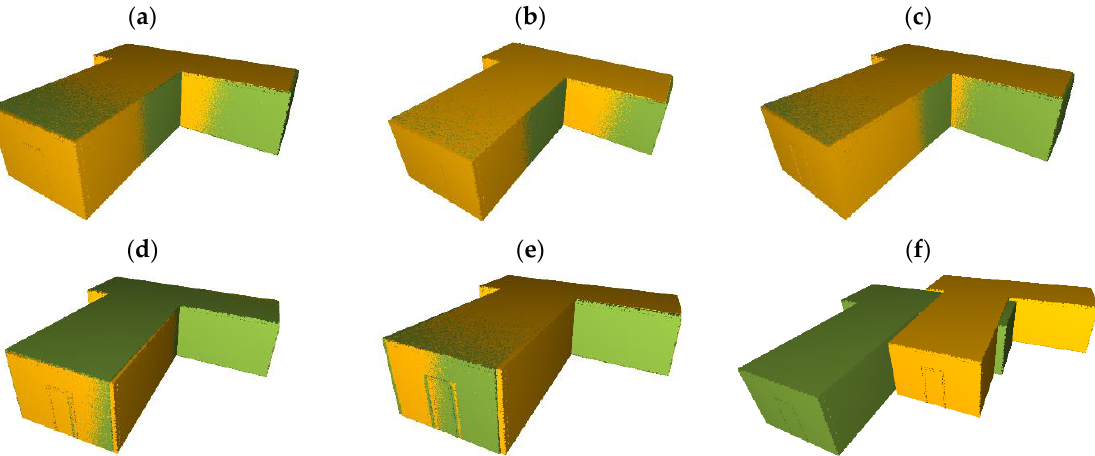
Figure 11. Visualization of the corresponding models registered with different translation vectors computed from the pairs of the most likely matched plane segments sorted according to their matching costs (𝜎) : ( a ) 𝜎(𝑡 𝑅 0 1 ) = 0.4304, (𝐛) 𝜎(𝑡 𝑅 0 2 ) = 0.4361, (𝐜) 𝜎(𝑡 𝑅 0 3 ) = 0.4423, (𝐝) 𝜎(𝑡 𝑅 0 4 ) = 0.4448, (𝐞) 𝜎(𝑡 𝑅 0 5 ) = 0.4783 and, (𝐟) 𝜎(𝑡 𝑅 0 6 ) = 0.5874.